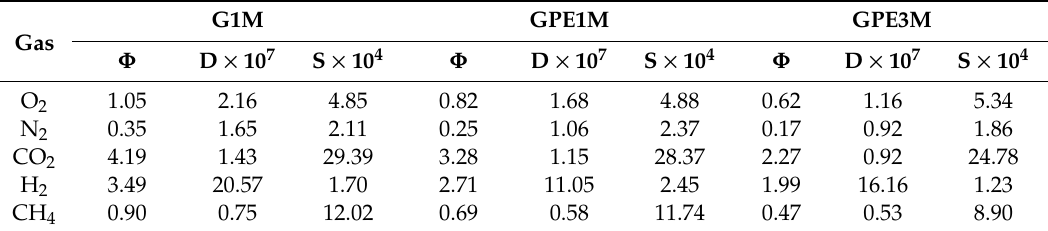
Table 4. Values of the permeability (Barrer), di ff usion (cm 2 s − 1 ), and apparent solubility (cm 3 / cm 3 cmHg) coe ffi cients of di ff erent gases at 30 ◦ C and 1 bar of pressure in the nanocomposite membranes used in this study and prepared by